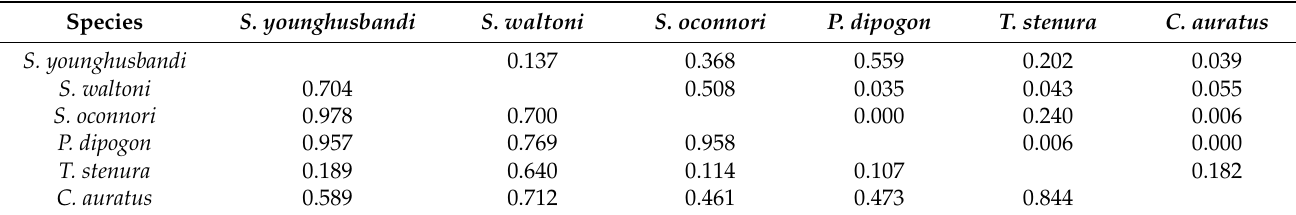
Table 2. Temporal and spatial niche overlap of main species in the Lhasa